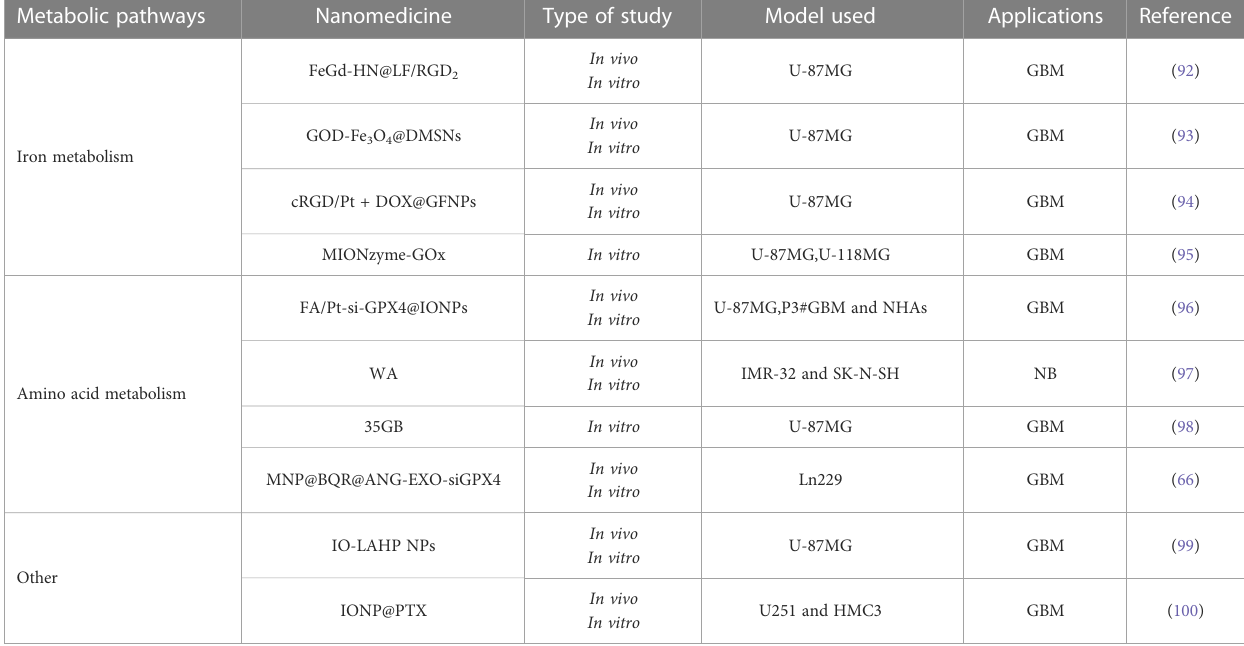
TABLE 2 Ferroptosis nano-delivery system based on different metabolic pathways. Metabolic